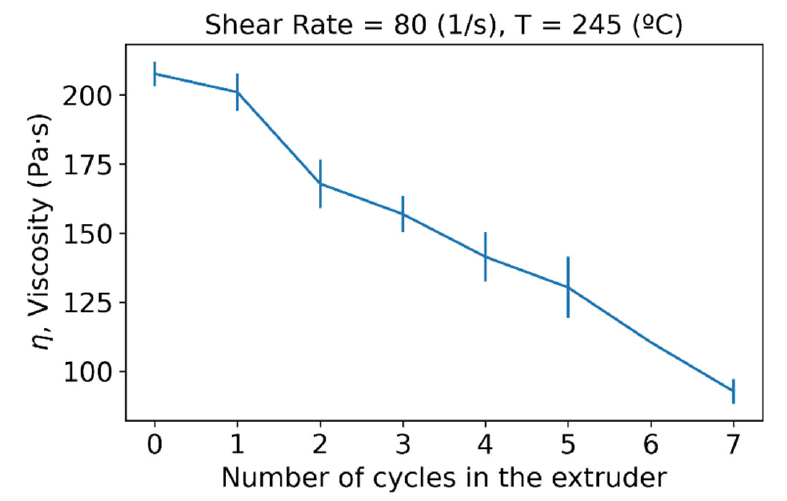
Figure 1. Viscosity variation with increasing number of cycles in the extruder. As raw material and recycled material (extruded seven times) are irradiated, the viscosity values of the materials show a clear dependence on the absorbed doses of gamma irradiation. Apparent viscosities of samples irradiated show significant differences from levels is almost negligible (Figure 2). This increment in viscosity can be explained through branching in the lower doses and crosslinking at the higher. It can be observed